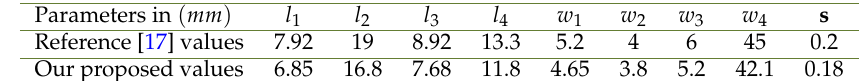
Table 2. Summary of the performance of the designed antenna compared to the method in the reference